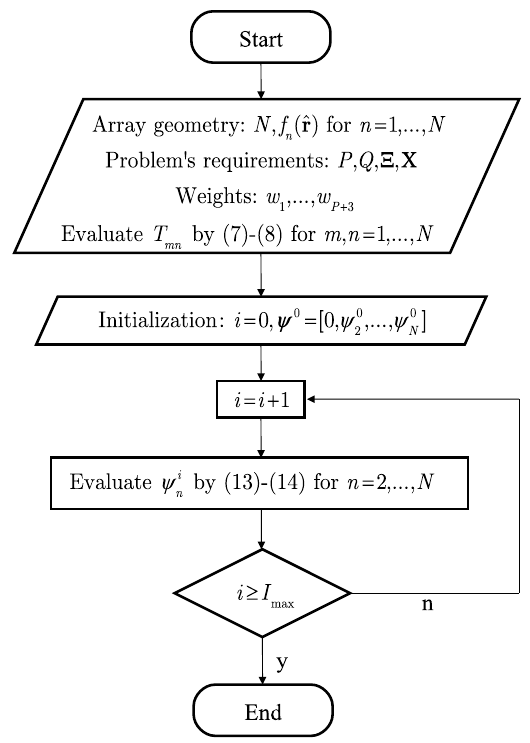
Figure 1. Proposed